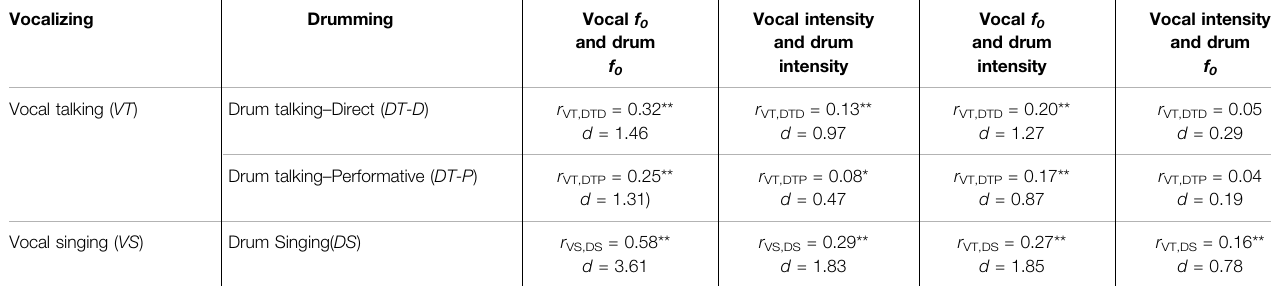
TABLE 4 | Rhythm-matched fundamental frequency and intensity correlations between different modes of vocalizing and their matched drumming modes. Vocalizing Drumming Vocal f 0